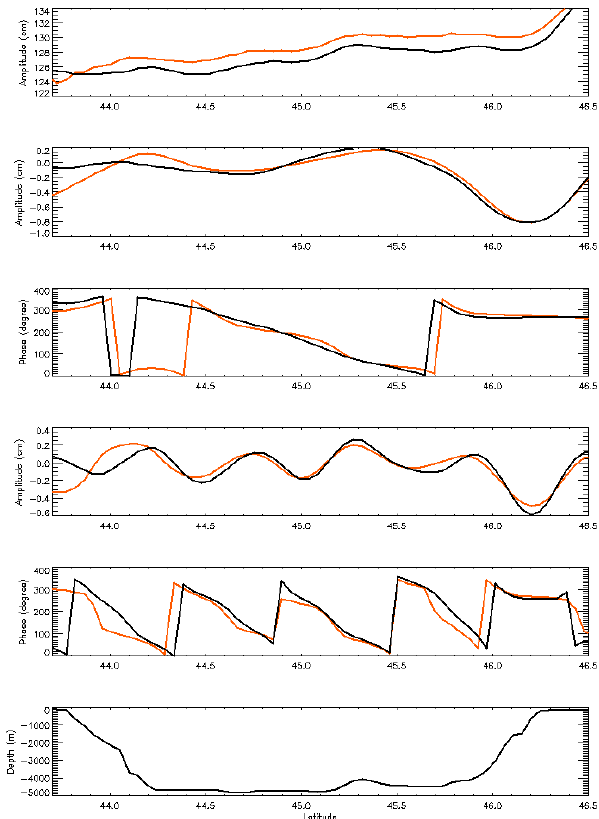
Figure 15: Temperature (°C) and salinity (psu) profiles in the upper 200 m at station Matxitxako Fig. 15. (a) Along-track amplitudes (cm) deduced from the M2 har- as a function of time (August 2007 to February 2009) from the observations (a, b) and from the monic analysis of altimetric data (red) and model (black). (b) Baro- model (c, d). As no measurement is available above 10 m, we show the model results below 10 m. clinic amplitudes in cm and (c) phase of the residual tides for the altimetric data (red) and the model (black) and for the first baro- clinic mode. (d) Baroclinic phased-locked elevations in cm and Fig. 16. Modelled (black) and observed (red) residual near-surface Figure 16: Modelled (black) and observed (red) residual near surface velocity (approximately (e) phase of the residual tides for the altimetric data (red) and the velocity (approximately along slope) at various moorings along the along slope) at various moorings along the Iberian slope (cm.s -1 ): northern component at Cabo model (black) and for the second baroclinic mode. (f) Along-track Silleiro and eastward component at Estaca de Bares and Bilbao. Iberian slope (cms − 1 ): northern component at Cabo Silleiro, and bathymetry (m). eastward component at Estaca de Bares and